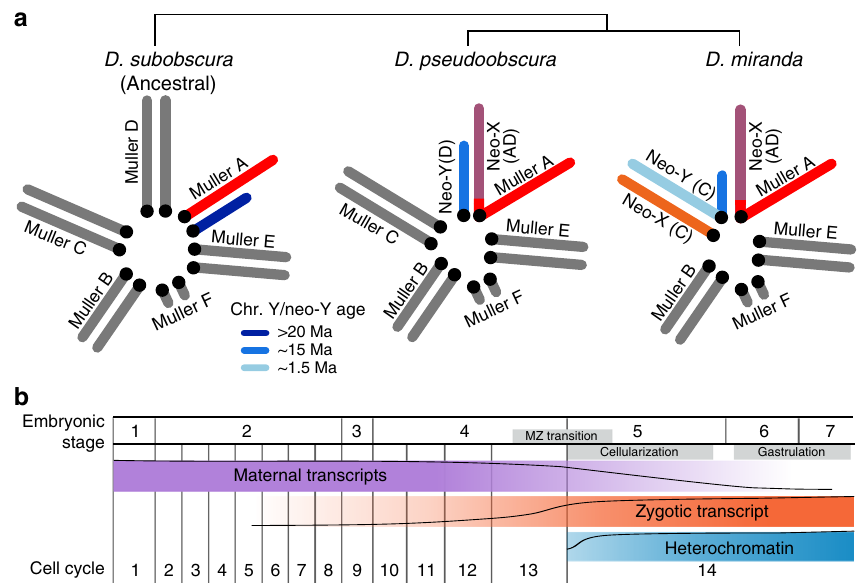
Fig. 1 Neo-Y chromosome emergence and transcriptional activity during early embryogenesis in Drosophila . a The male karyotypes of three species in the obscura species group showing three different Y and neo-Y (blue) chromosome con fi gurations. Chromosome arms are labeled as Muller Elements. The X/neo-X chromosomes are in warm colors and autosomes in gray. Drosophila subobscura represents the ancestral karyotype. D. pseudoobscura has a highly degenerate and old neo-Y that formed 15 Ma after the fusion of the X (Muller A) with Muller D, creating a neo-X chromosome. D. miranda has a young neo- Y that formed after Muller C fused with the Y ~1.5 Ma. The unfused Muller C then became the neo-X. b Schematic representation of transcriptional changes and heterochromatin regulation in early embryonic development 15 – 19 . The approximate abundance of maternal transcripts (purple), zygotic expression (orange), and repressive heterochromatin (blue) are